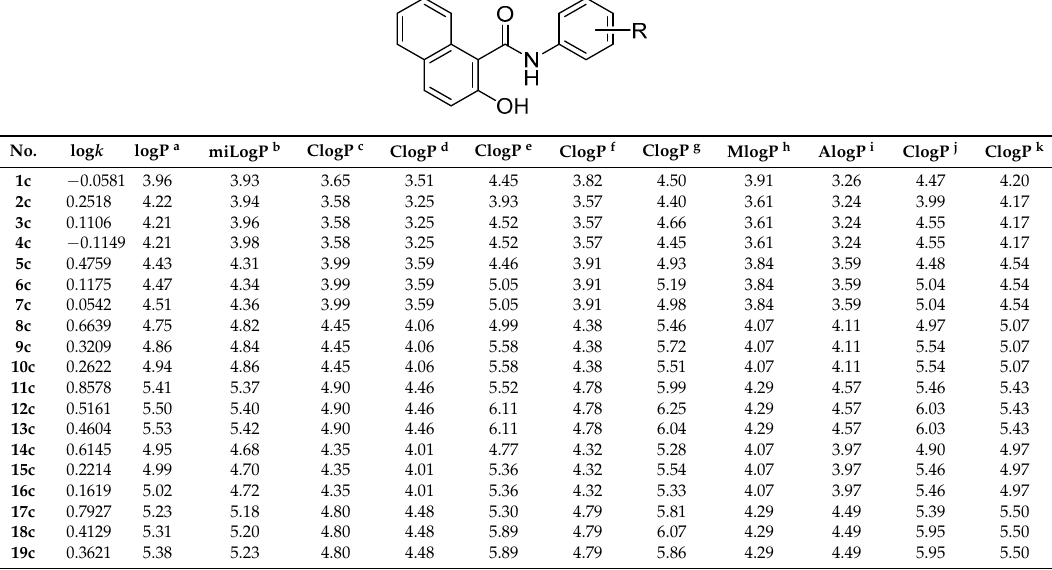
Table 3. N -substituted 2-hydroxynaphthalene-1-carboxanilides 1c – 19c (series C), as well as their determined log k and theoretical partition coefficients calculated by alternative methods.